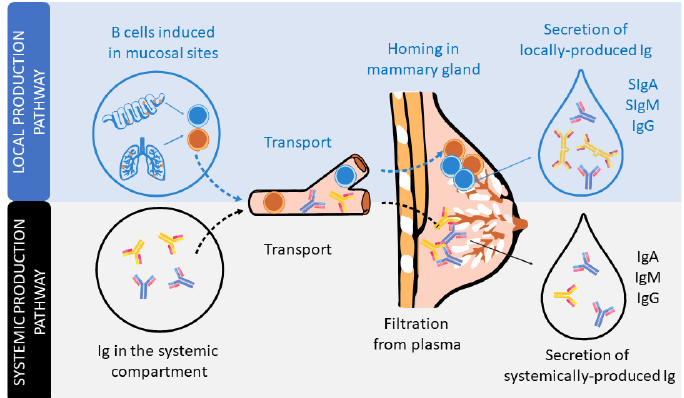
Figure 1. The secretion of Igs in human milk. Schematic figure of the local production pathway of Igs (involving the B cell homing to the mammary gland and participation of the secretory compo ‐ nent) and the systemic production pathway (involving the monomeric Igs plasma filtration from